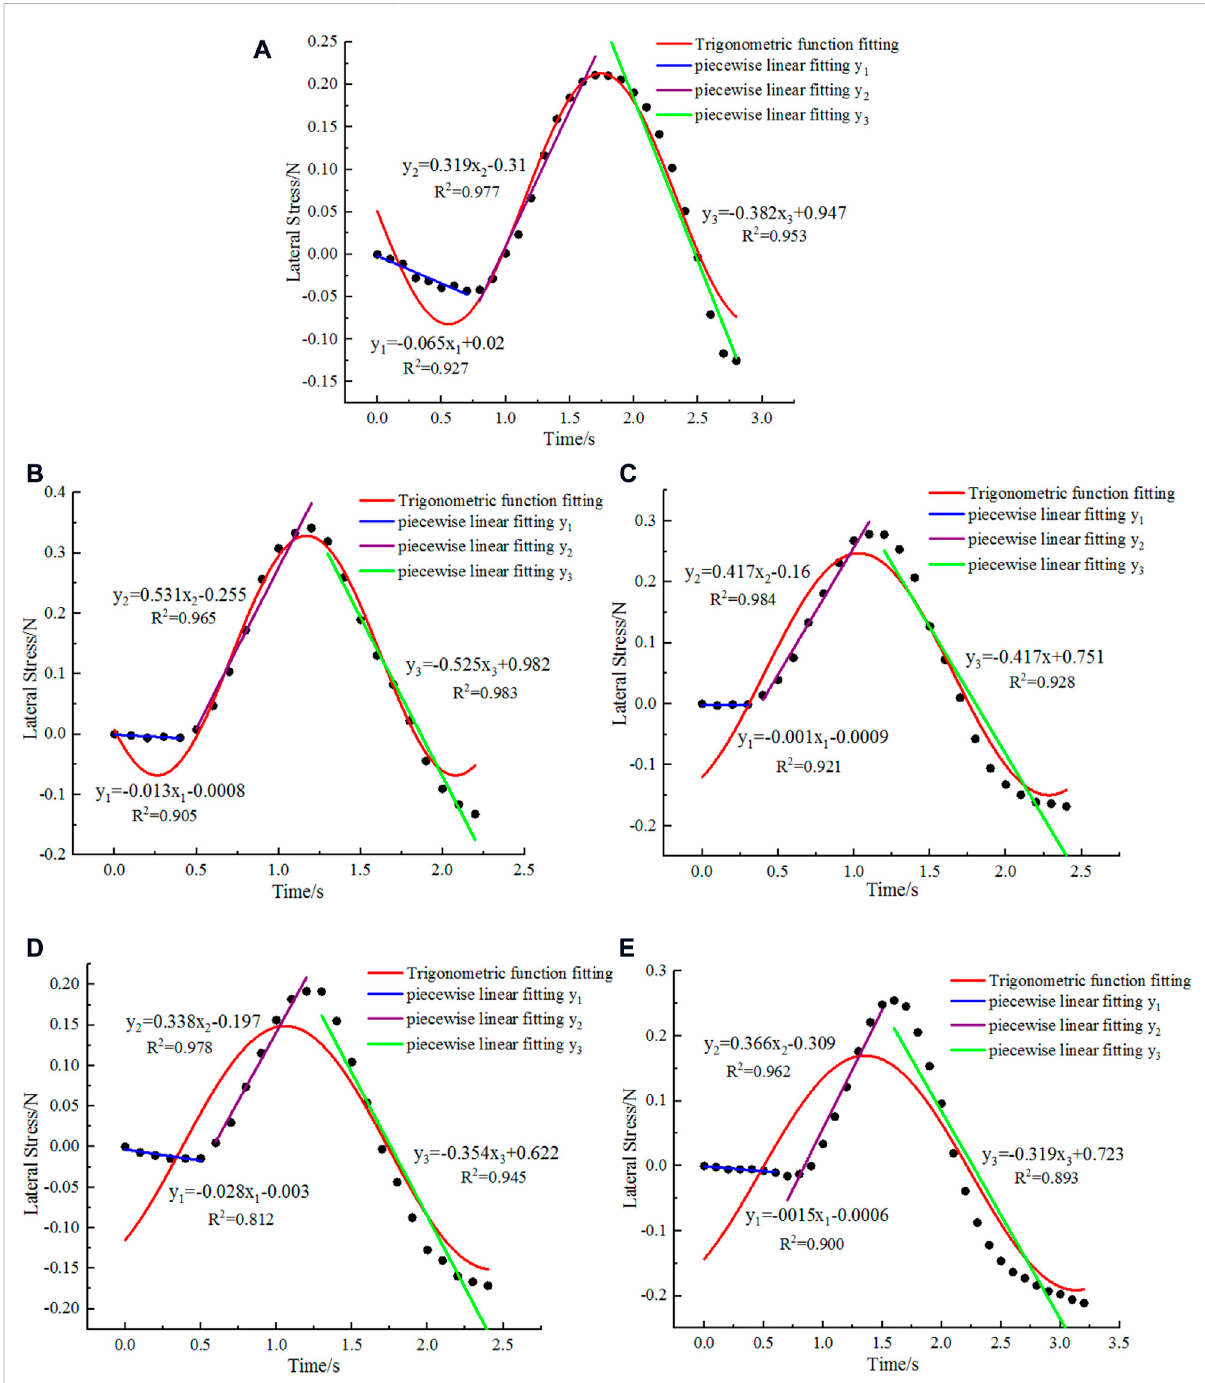
FIGURE 6 Temporal variation in lateral stress at different lateral positions in the shallow soil layer: (A) 20 mm; (B) 40 mm; (C) 60 mm; (D) 80 mm; and (E) 100